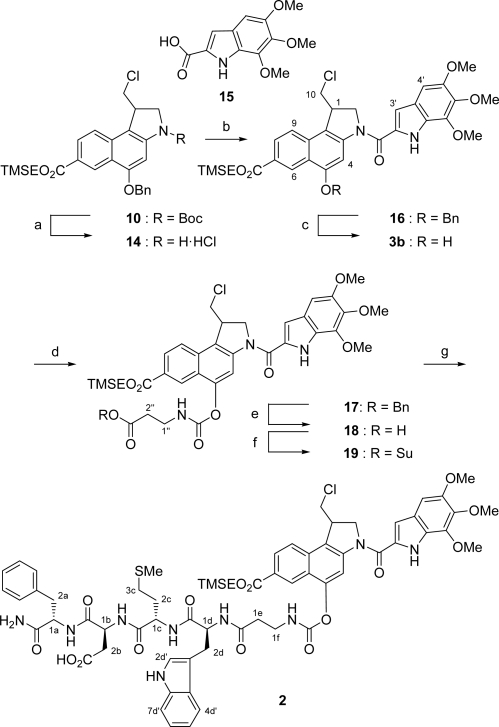
Synthesis of carbamate prodrug 2. a) HCl/EtOAc, Et3SiH, CH2Cl2, 20 °C, 7 h; b) TMI-CO2H (15), EDC·HCl, DMF, 20 °C, 1 d, 43% (two steps); c) Pd/C, NH4HCO2, THF/MeOH, 20 °C, 75 min, quant.; d) isocyanate 13, NEt3, CH2Cl2, 0–20 °C, 16 h, 83%; e) Pd/C, NH4HCO2, THF/MeOH, 20 °C, 25 min, 90%; f) HOSu, EDC·HCl, THF/CH2Cl2, 0–20 °C, 15 h; g) tetragastrin (20), NEtiPr2, H2O/DMF, 20 °C, 7 h, 57% (two steps).